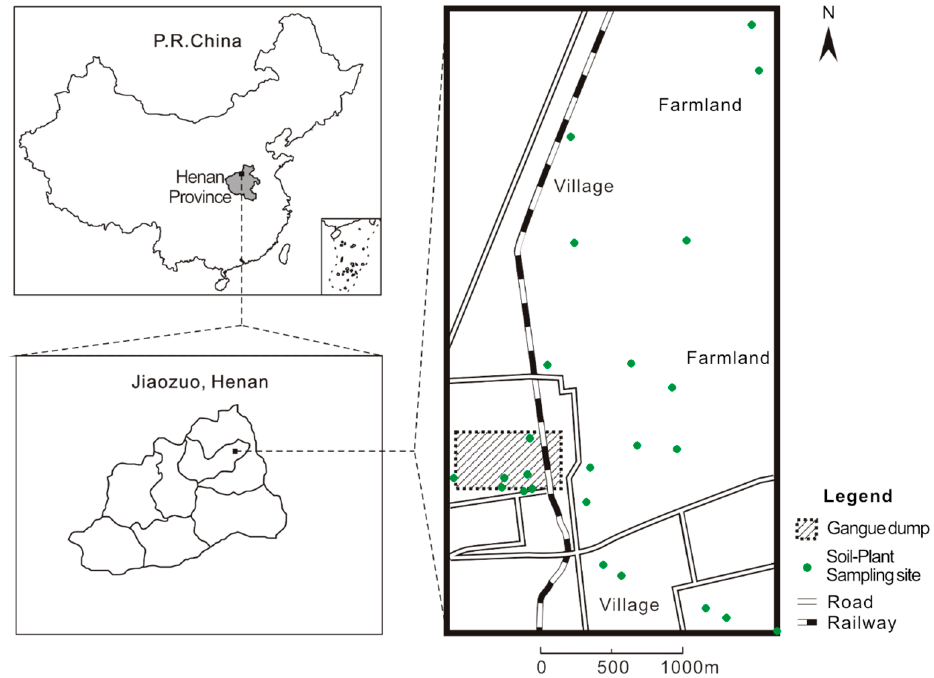
Figure 1. Map showing the research area and sampling sites.